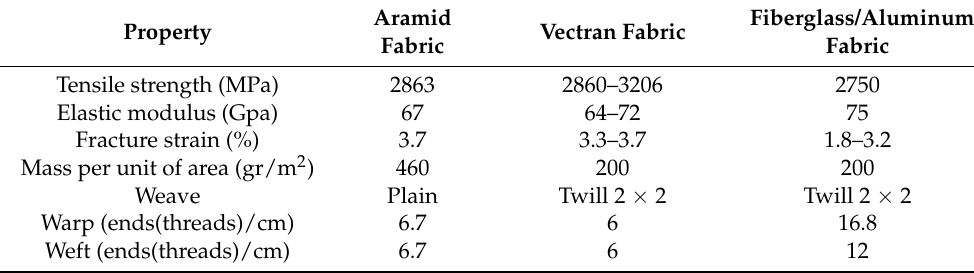
Table 1. Mechanical-properties of composite